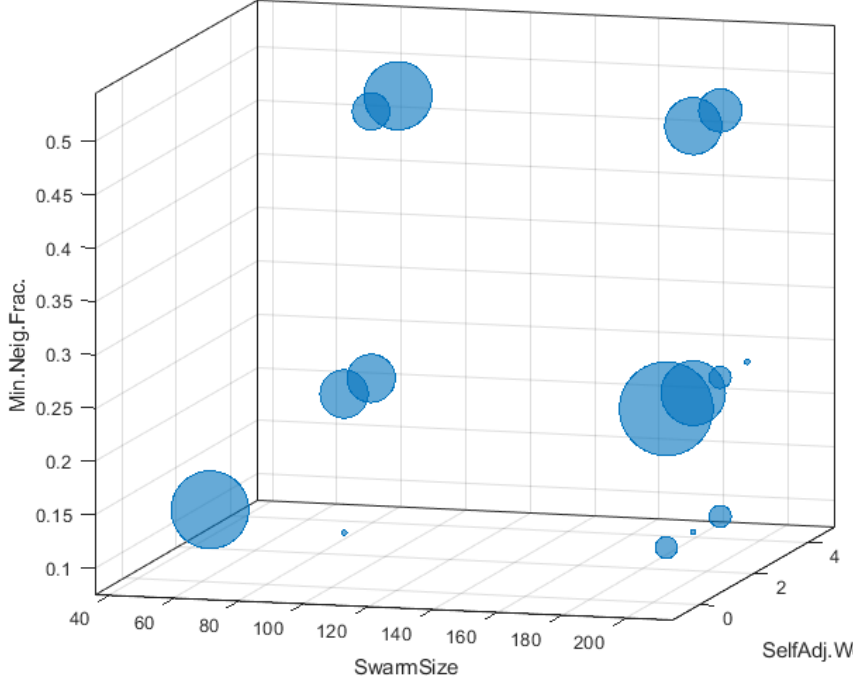
Figure 18. Bubble visualization of quantitative results of different PSO configurations. Table 8. Sum of correct results using specific PSO parameters. Colour code: green → the best;